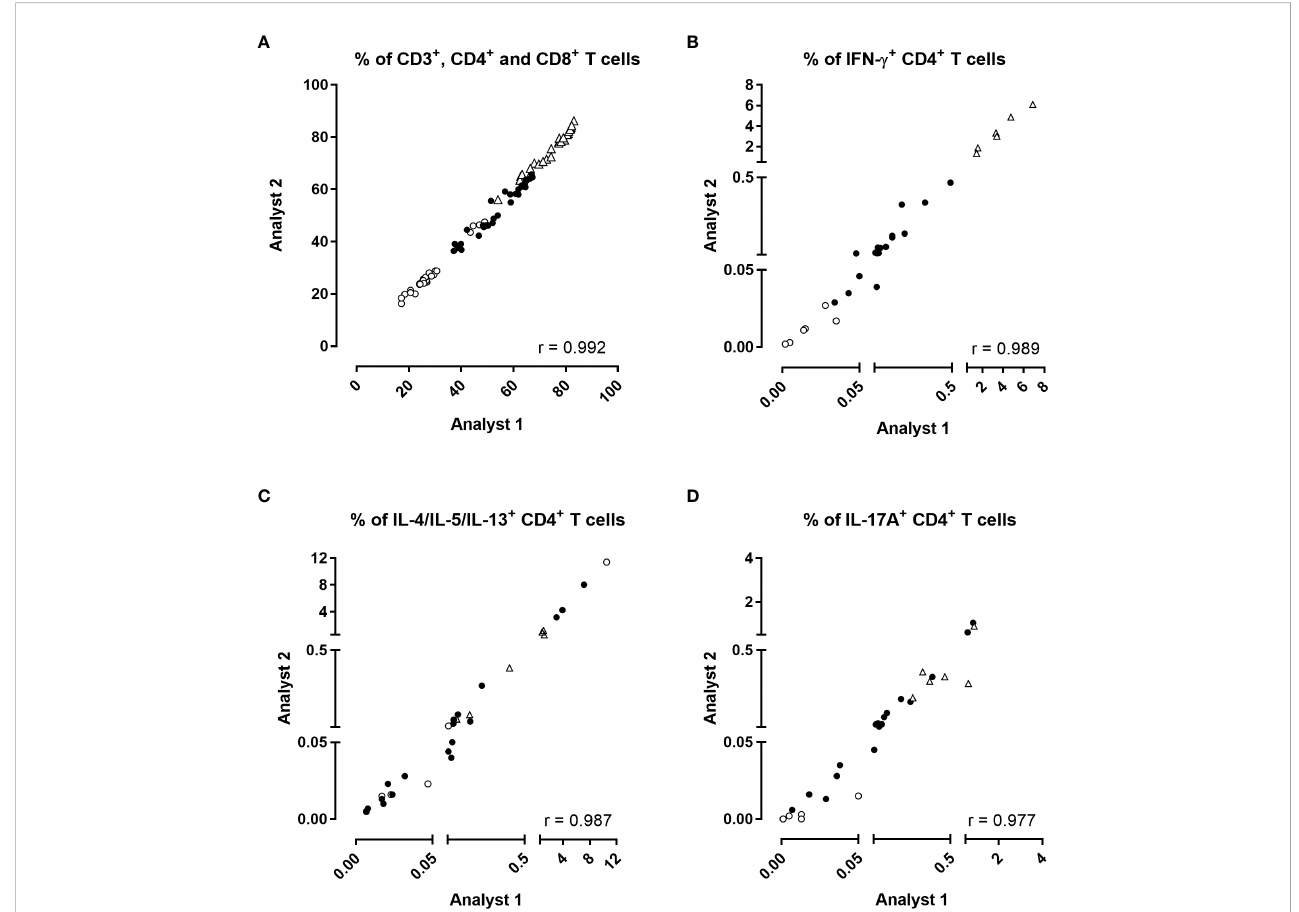
FIGURE 3 Inter-operator reproducibility of the analysis. The percentages of (A) CD3 + (open triangles), CD4 + (black circles), CD8 + (open circles) T cells, and the percentages of (B) IFN- g , (C) IL-4/IL-5/IL-13 or (D) IL-17A/IL17-F-producing CD4 + T cells obtained by two different operators were compared two by two for each stimulation condition after direct staining of the cells. Diluted blood was incubated during 24 hrs with 5 µg/ml PT, 5 µg/ml FHA or 10 µg/ml BPL (black circles). Negative (no antigen, open circles) and positive (SEB, open triangles) controls were used in parallel. Thirty comparisons were performed on samples from four adults (n°6-9), and two 5-6 years-old children, all recently aP vaccine boosted. The cells were fi xed, directly permeabilized, and stained with antibody panel 2, optimized for the detection of Th2 and Th17-type responses (Table 1). The acquisition was performed on a LSR Fortessa fl ow cytometer, and FlowJo software (version 9.5.3) was used for the analysis. Correlations were evaluated by a non-parametric Spearman test with Graphpad Prism 7.03 software (Graphpad software, La Jolla, CA,